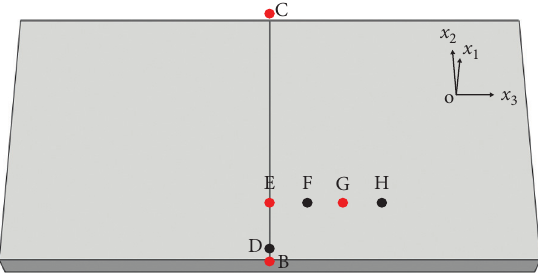
Figure 2: Sensor and load distribution on the steel plate.